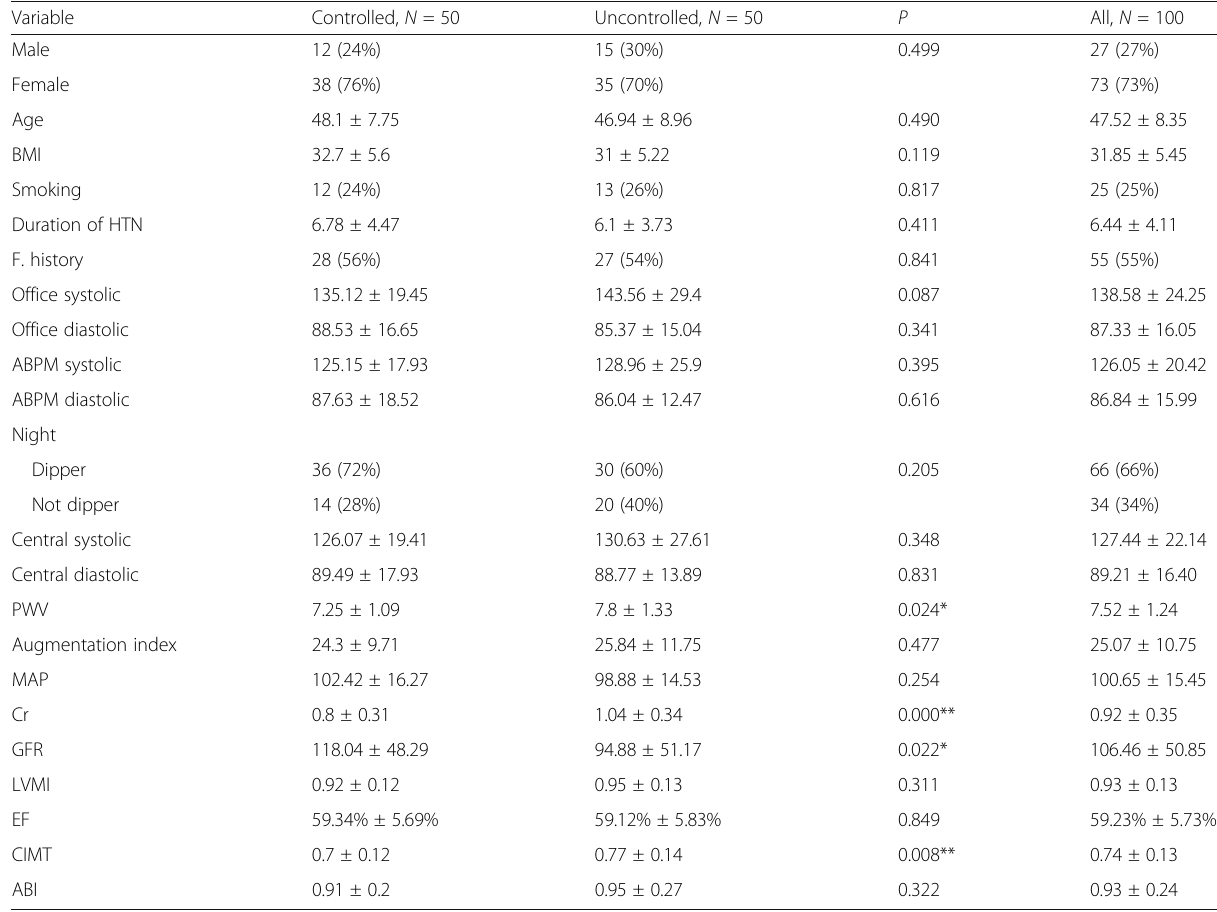
Table 1 Characteristics of the controlled versus uncontrolled groups with office blood pressure measurement